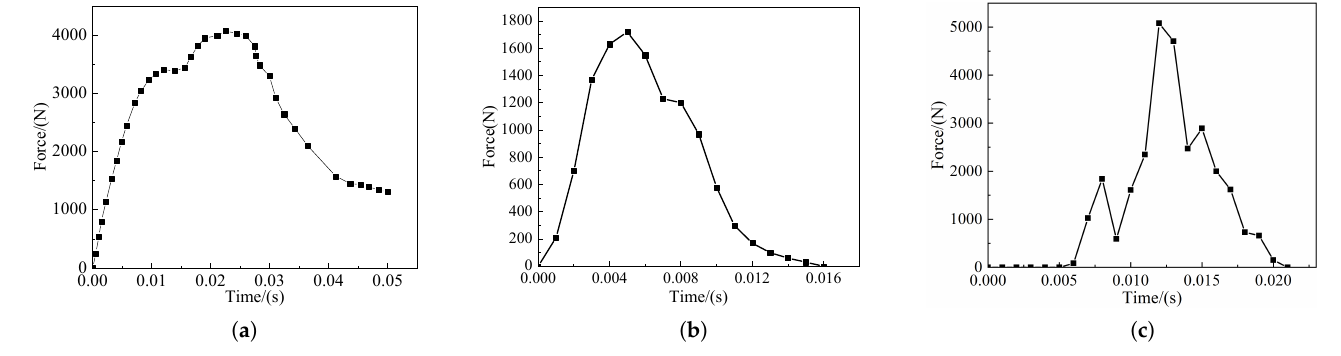
Figure 14. Force-time collision curves: ( a ) Force-time curve for cadaver testing; ( b ) pendulum simulation force–time curve of the pig model; ( c ) pendulum simulation force–time curve of the cow